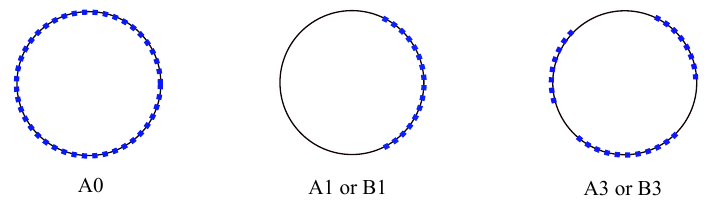
Figure 1 . For the A 0 case the density of eigenvalues has support on the full circle. For A 1 the support is on an arc. More complicated cases exist with support on many